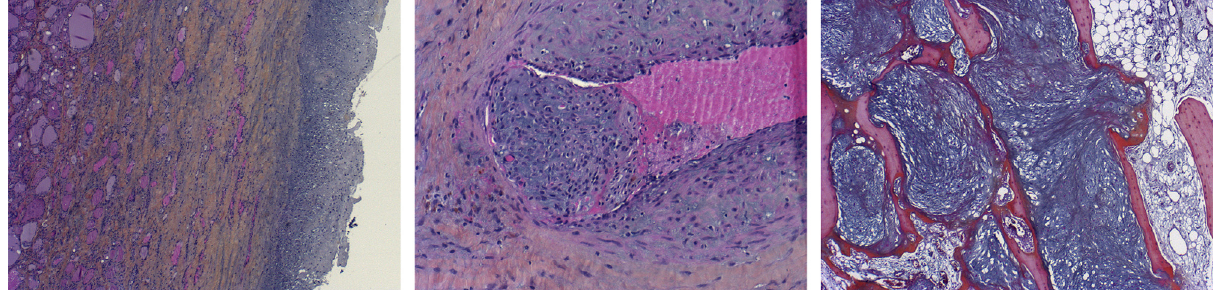
Figure 1 Comparison of histology of the initial chondrosarcoma (right) and thyroid metastasis 14 years later (left and center). Both lesions were confirmed to be identical by a laboratory specialized in sarcoma (Oscar Lambret in Lille, France). Left: thyroid metastasis, HES staining × 2.5; myxoid tumor infiltrating the thyroid tissue and dissociating thyroid vesicles. Center: vascular invasion in the thyroid metastasis; HES staining × 10; cluster of dedifferentiated chondrocytes in a myxoid stroma, covered by an endothelial layer in a vessel lumen. Right: femur chondrosarcoma, HES staining × 2.5; showing massive bone resorption by a myxoid and chondroid tumor.